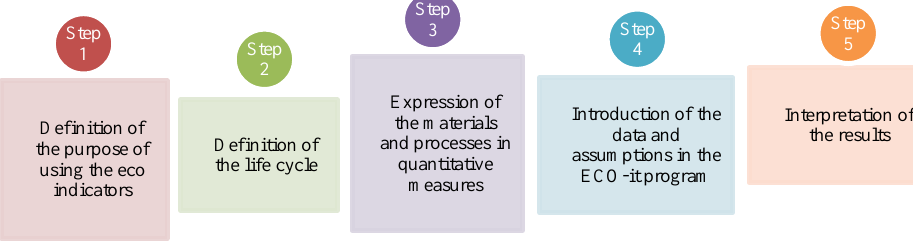
Fig. 1. Step-by-step principle implemented in the